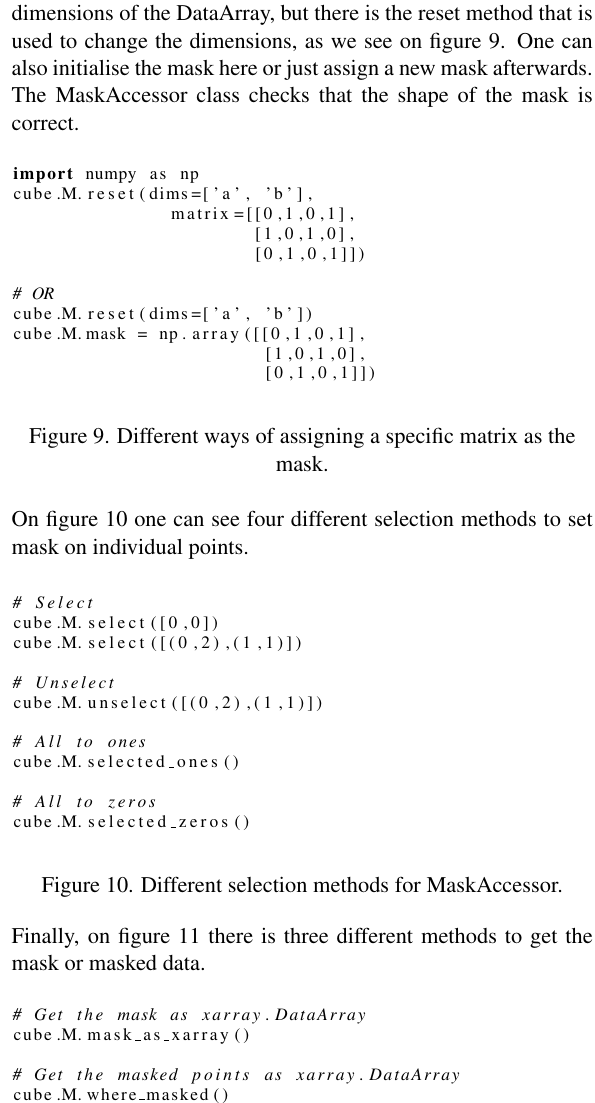
Figure 8. When the accessor is imported, every xarray